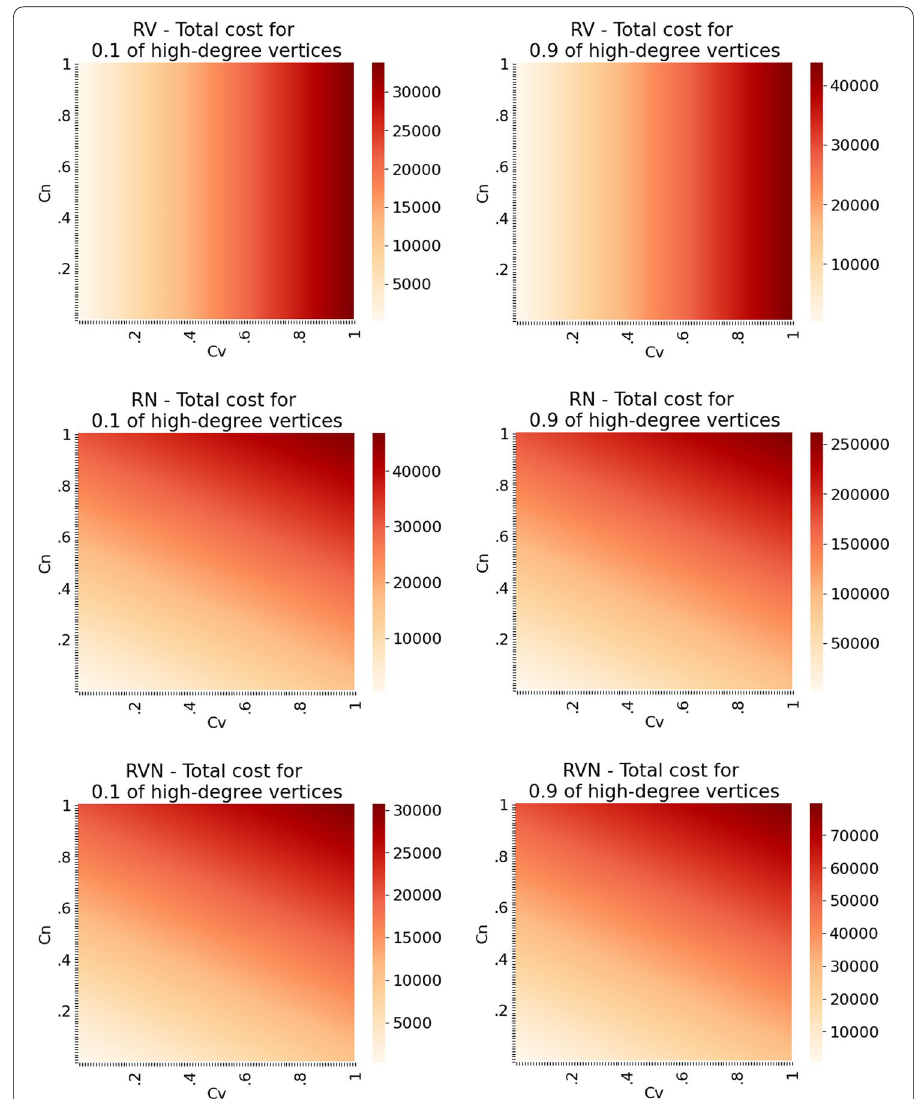
Fig. 6 Heat maps representing the effects of C v and C n (sampling) costs for the top 10% and 90% of high‑degree